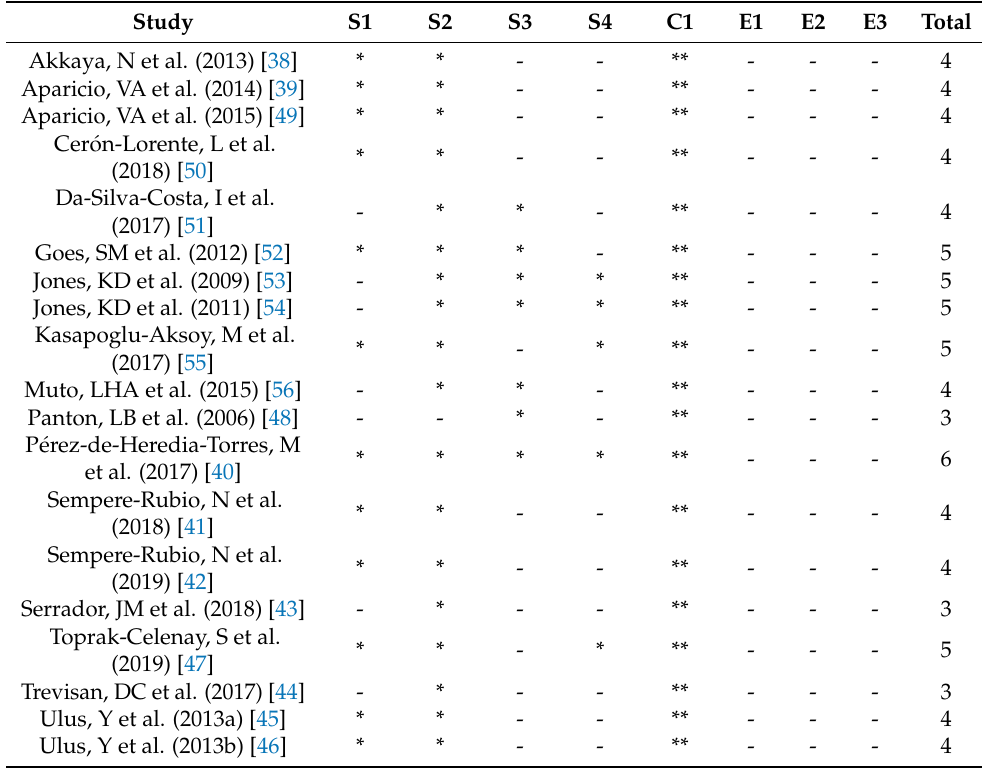
Table 3. Newcastle-Ottawa Scale (NOS) scores for the methodological quality assessment of included